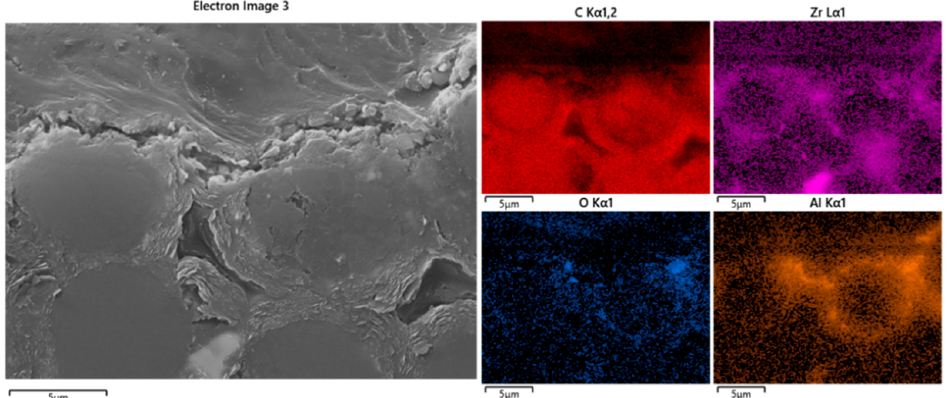
Figure 14. Cross-sectional SEM/EDS mapping of the ablated region obtained after using 2 % Al propellant.